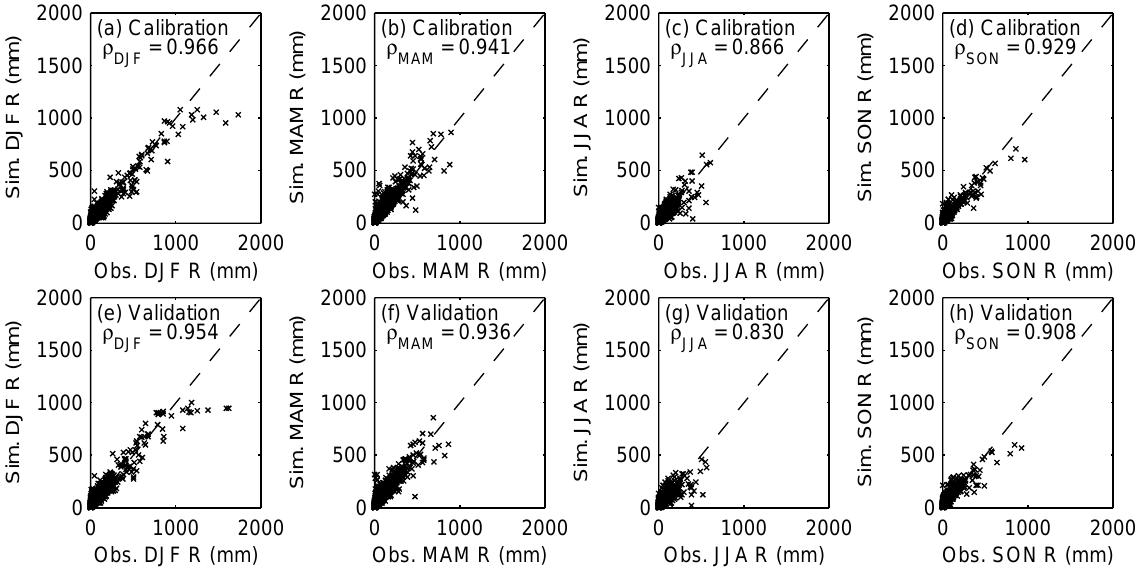
Fig. 11. The USGS WaterWatch observed runoff ( x axis) versus the VIC simulated seasonal total runoff (surface runoff + base flow, y axis) for both calibration periods (a) – (d) and validation periods (e) – (f) for each HUC8 subbasin. Winter runoff from December to February is plotted in (a) and (e) , while spring runoff from March to May in (b) and (f) , summer runoff from June to August in (c) and (g) , and fall runoff from September to November in (d) and (h)